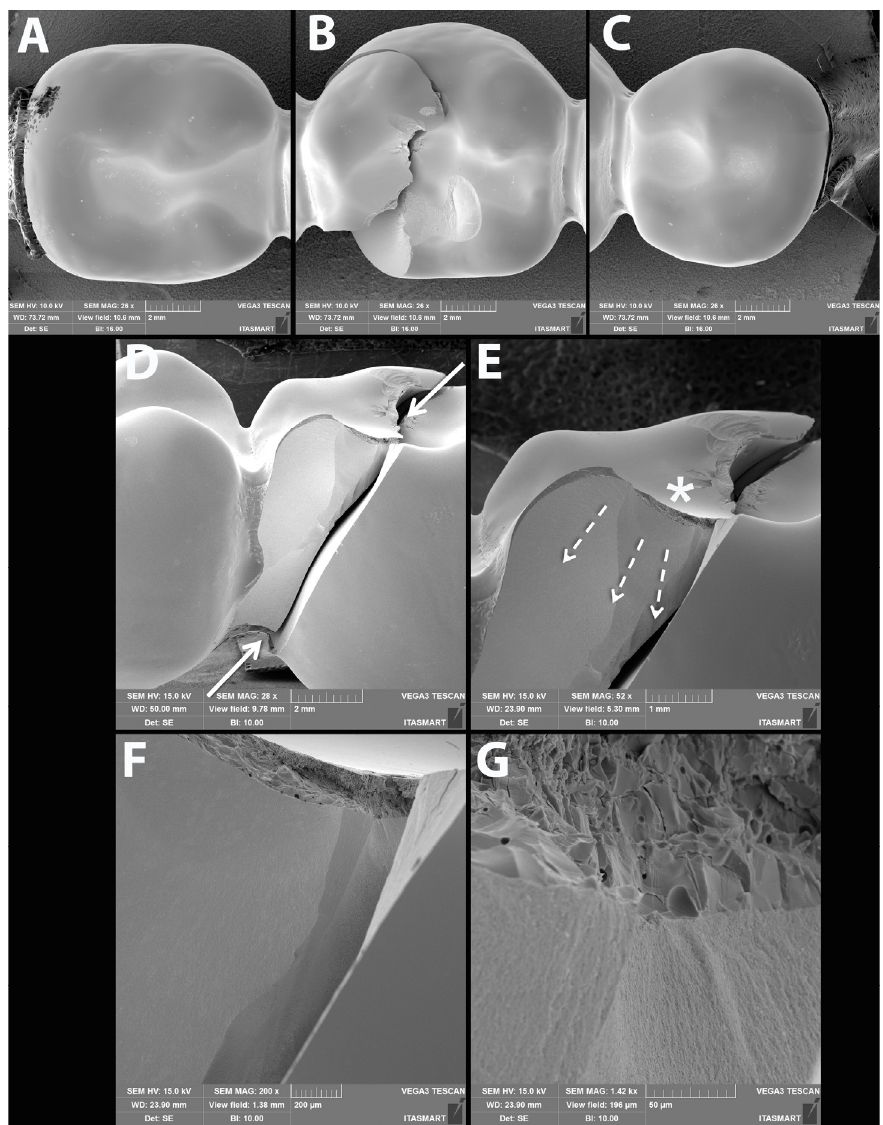
Figure 7. Meaningful specimen of Group Z-ST after single-load-to-failure assessment. ( A – C ) are an overview of the occlusal surfaces of an entire monolithic Z-ST FDP showing intact abutments ( A , C ) and the fractured pontic ( B ). The buccal view in ( D ) shows a crack that connects the occlusal surface to the gingival portion of the connector of the pontic. Magnifications of the buccal surface are shown in the subsequent images where the asterisk indicates the possible fracture origin site and the dotted arrows the direction of crack propagation ( E ). ( F , G ) are magnifications of the damage caused by the indenter at the occlusal surface.